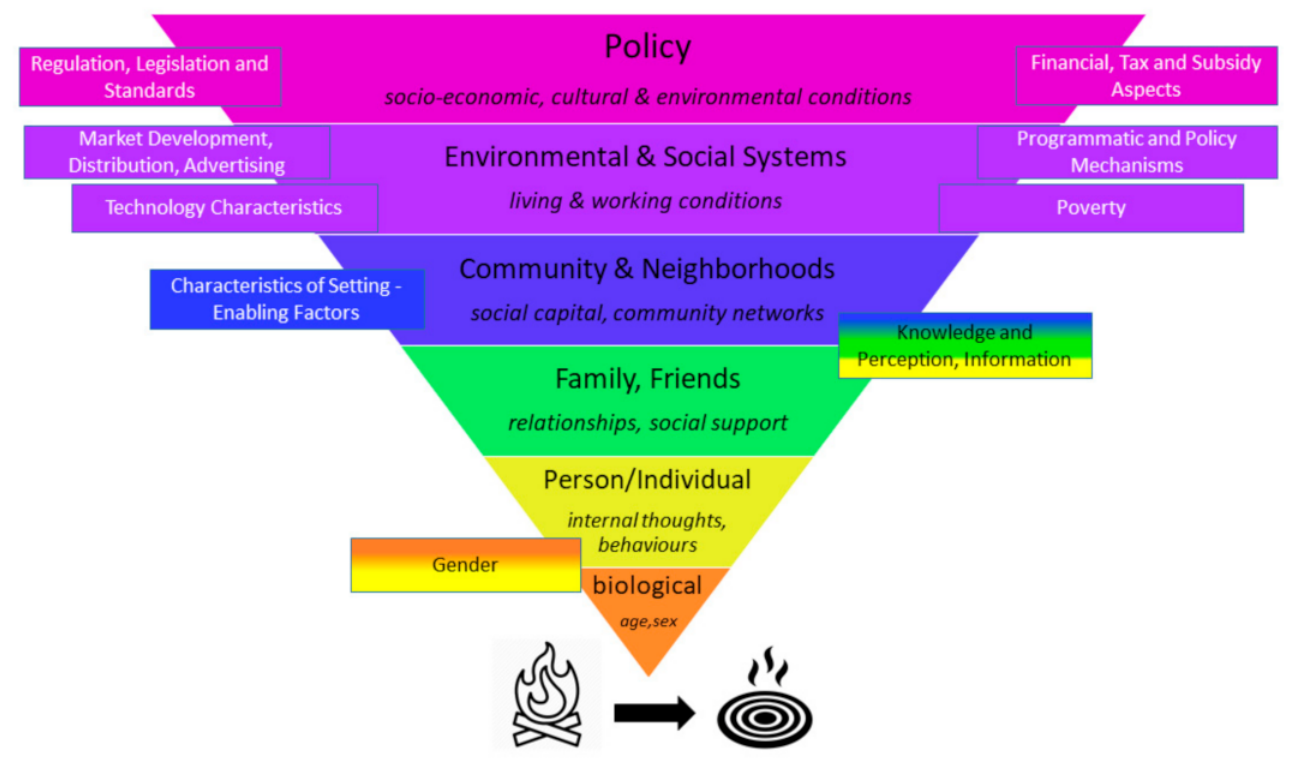
Figure 1. A modified Dahlgren–Whitehead model of the relationships between an individual and her